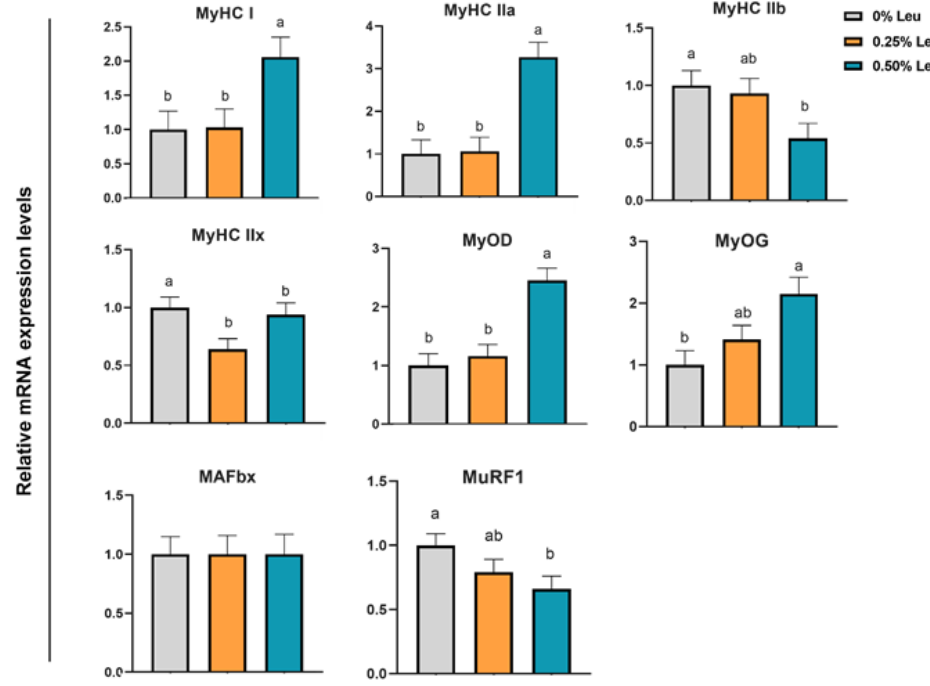
Figure 3. Relative mRNA expression levels of f key genes related to muscle fiber growth in longissimus dorsi muscle. Leu: Leucine. a,b Different superscript letters on the same line are significant differences ( p < 0.05).